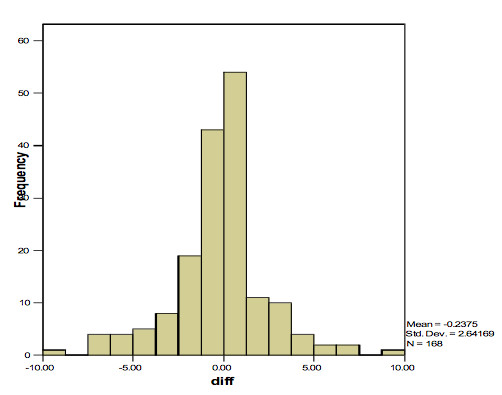
Distribution of differences between multiple taste test assessments in the ALSPAC cohort. Distribution of differences observed between general visual analogue scale scores for the description PROP taste test results within 168 repeat tested children from the ALSPAC cohort. Mean difference between two measures is 0.24(0.16, 0.64), p = 0.25.